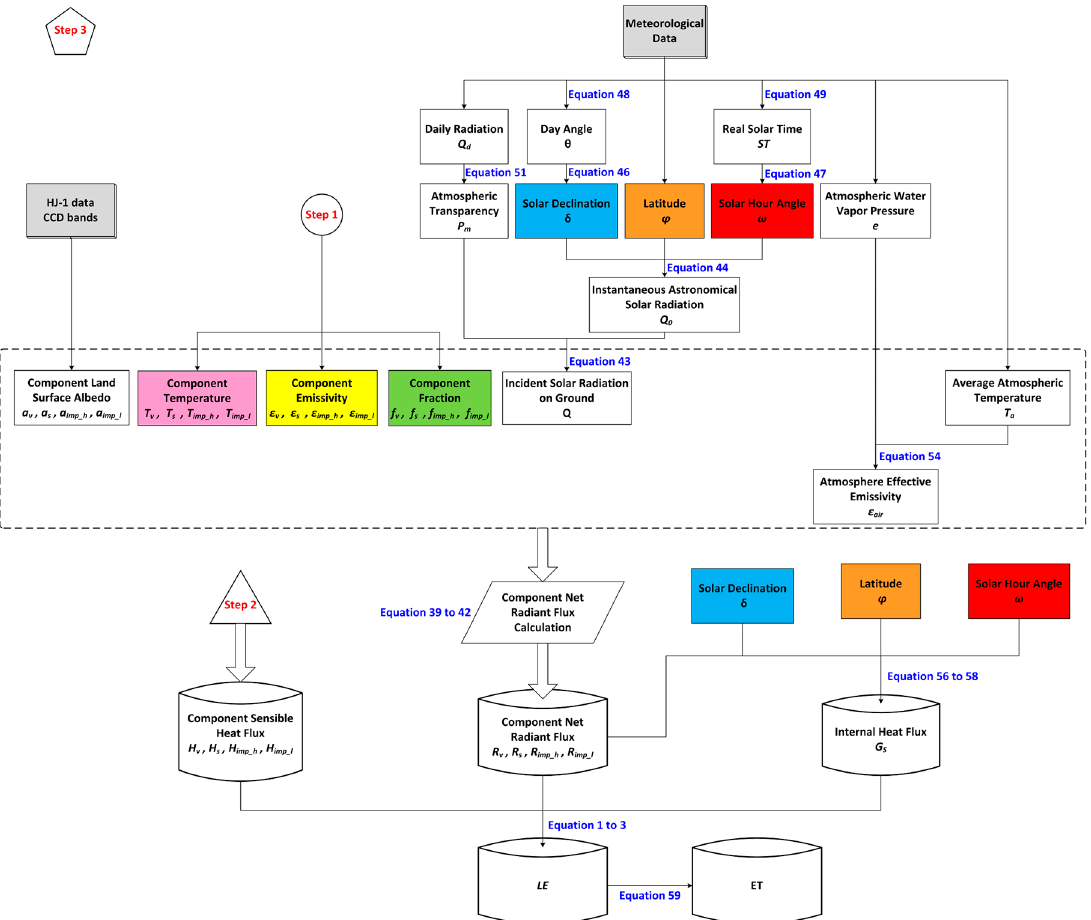
Figure 11. Flowchart of the third step (Step 3) for Sections 3.4–3.6.